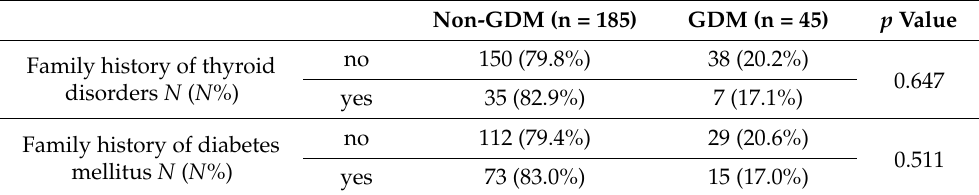
Table 2. Family history of hereditary conditions.